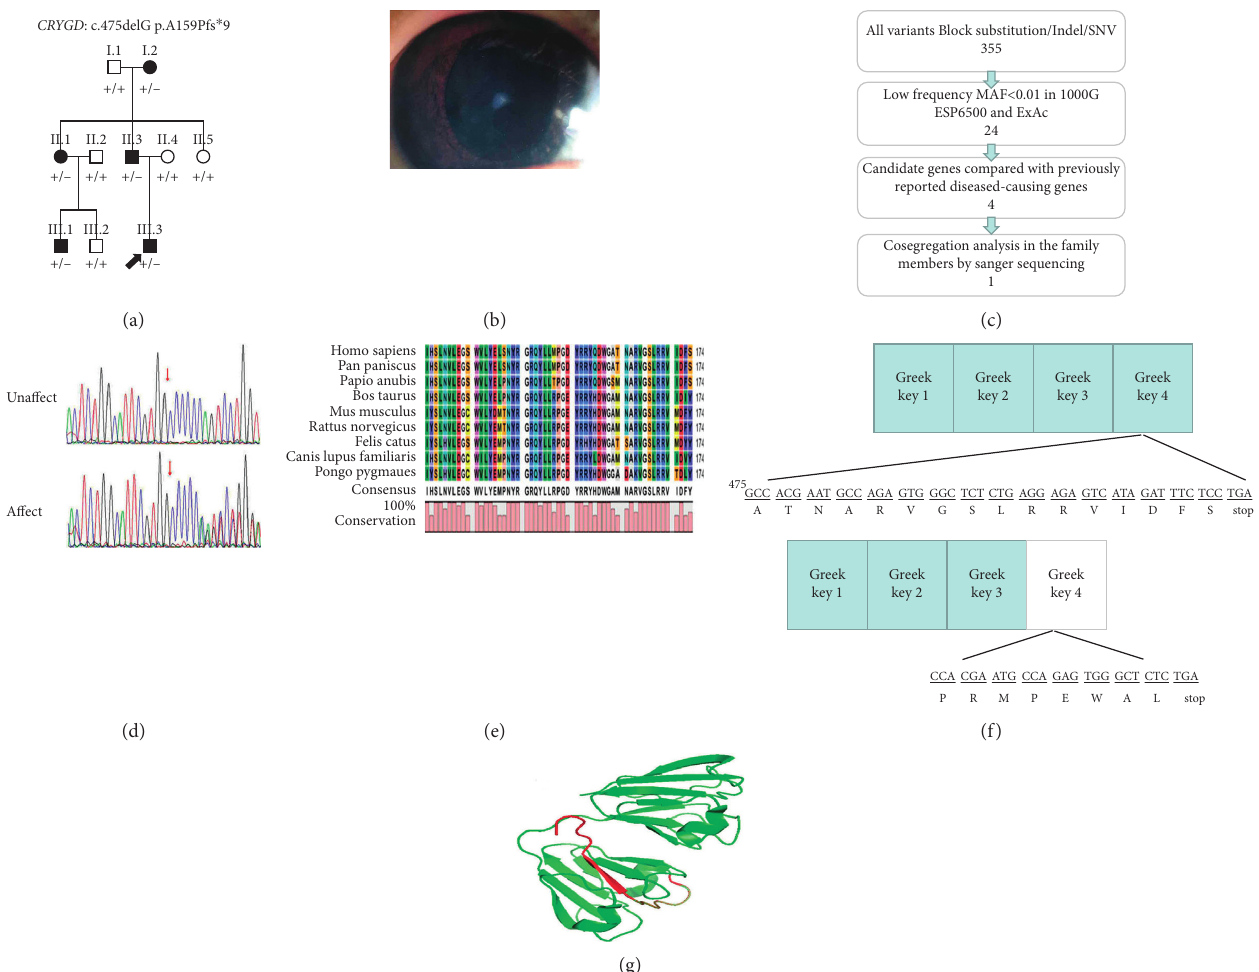
Figure 3: (a) Pedigree of ADCC family C The solid black arrow indicates the proband (III.3). (b) Photographs of the proband’s (III.3) lens are shown. (c) Schematic representation of the filter strategies employed in our study. (d) Sanger sequencing results. (e) Multiple protein sequence alignment. (f) The identified variant, CRYGD : c.475delG; p.A159Pfs ∗ 9, generated a frameshift and premature termination from a position 9 codons downstream (p.A159Pfs ∗ 9) of the variant; these alterations resulted in a protein that was reduced to half the length of the full-length protein. (g) The structures of the CRYGD proteins were modelled in